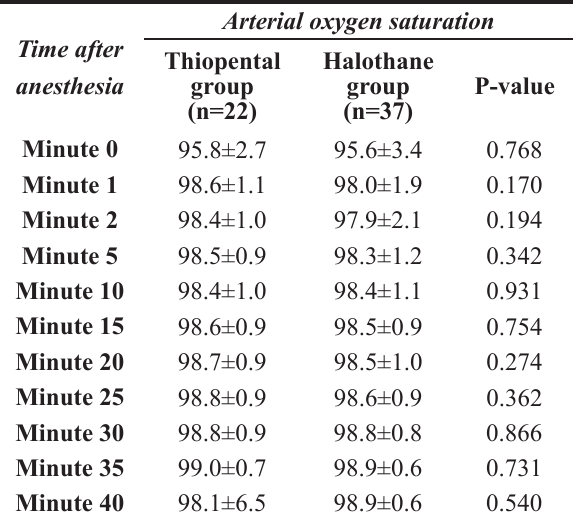
TABLE 4 - Comparison of arterial oxygen saturation